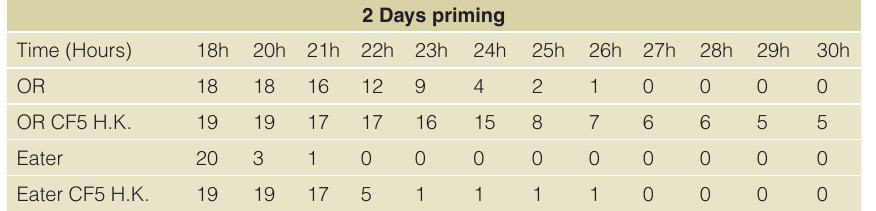
Table S4. Survival kinetics of wt and cellular response deficient flies 2 days post priming with heat-killed Pseudomonas aeruginosa CF5. Oregon R (OR) (n=18) and Eater (n=20) mutant uninfected flies, and primed with heat-killed (H. K.) CF5 bacteria were inoculated at 2 days with the virulent PA14 strain. Top row numbers indicate the time in hours post challenge whereas lower rows indicate the corresponding number of surviving flies in naive and primed flies respectively for each genotype. Sample size is indicated at 18h. 2 Days priming Time (Hours) OR OR CF5 H.K. Eater Eater CF5 H.K.